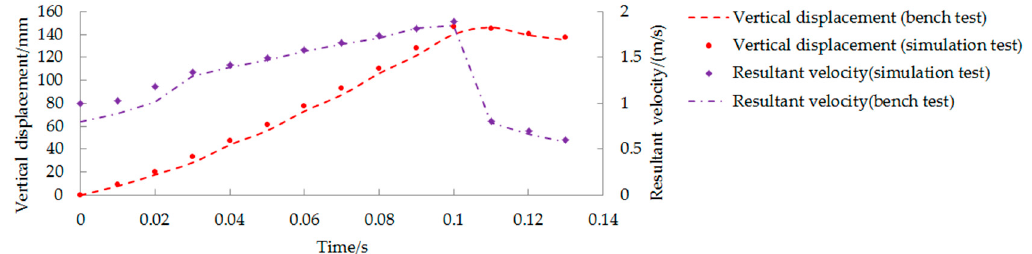
Figure 11. Curve of rice grain collision.